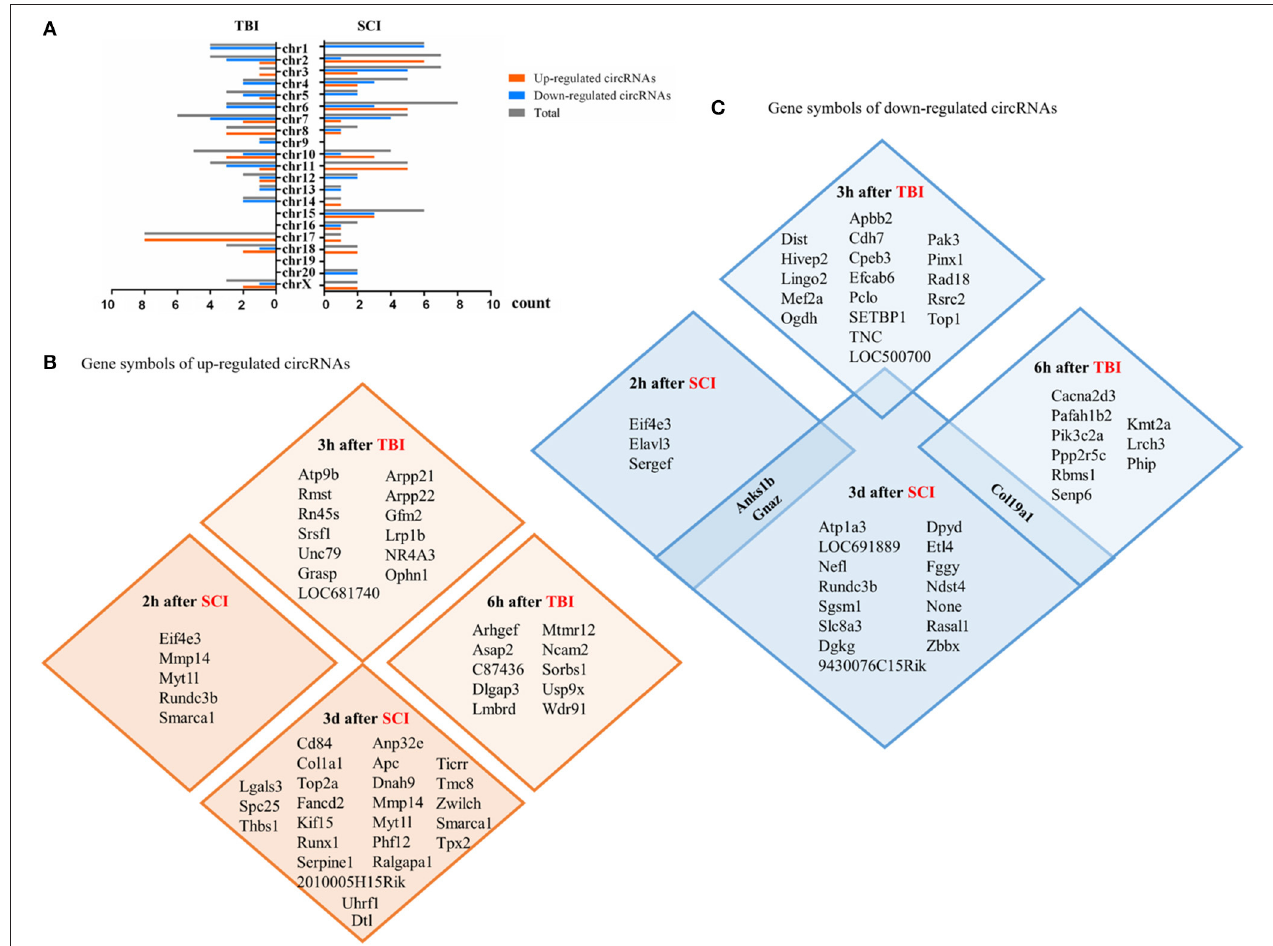
FIGURE 1 | Differentially expressed circular RNAs (circRNAs) (within the top 5–10 upregulated or downregulated in different studies) in CNS post-traumatic injury. (A) The distribution of differentially expressed circRNAs on chromosomes. (B) The gene symbols of upregulated circRNAs at different time points in the injury site. (C) The gene symbols of downregulated circRNAs at different time points in the injury